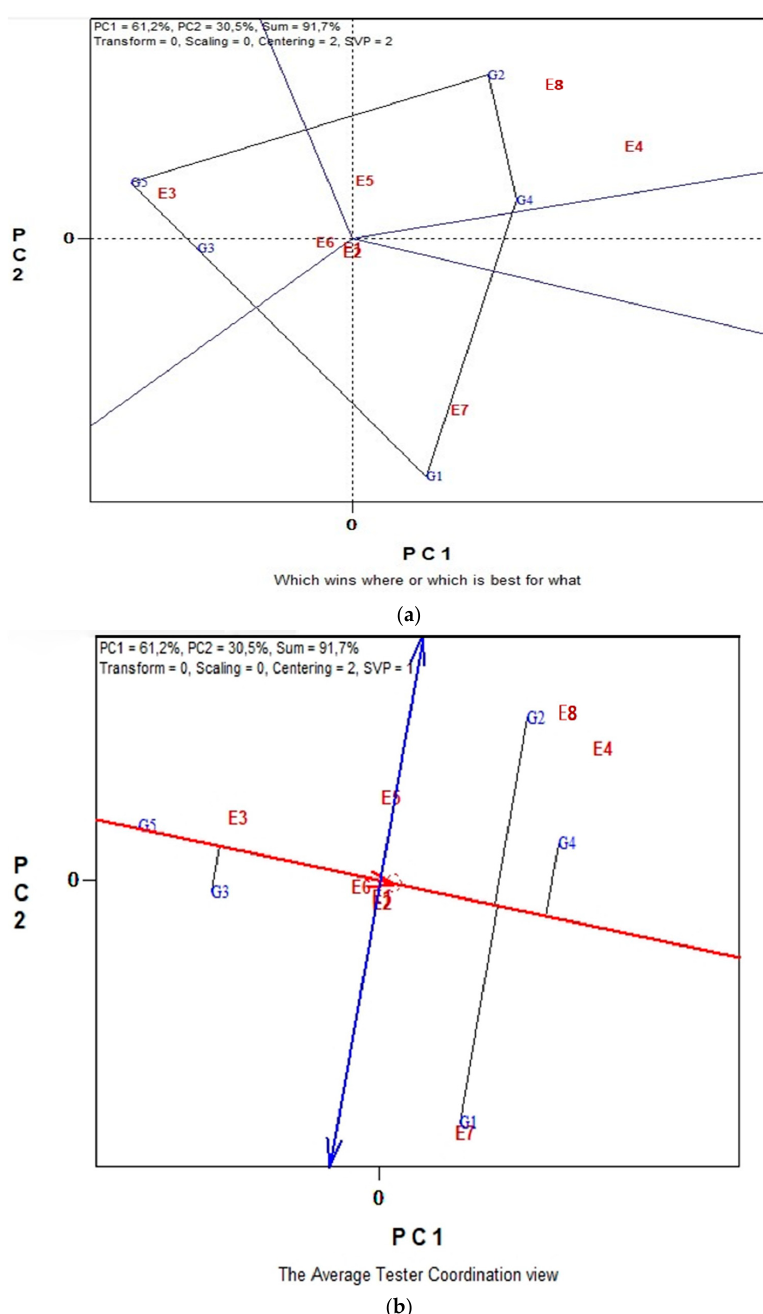
Figure 1. Biplot analysis in organic farming: ( a ) “which-won-where or which is best for what” view of the GGE biplot based on seed yield of five lentil genotypes in eight environments. Environment 1 and Environment 2 coincide; ( b ) “discriminating power vs. representativeness” view of the GGE biplot based on yield of five lentil genotypes in eight environments. Environment 1 and Environment 2 coincide.